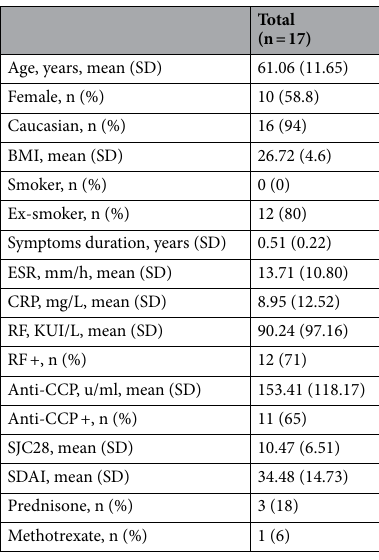
Table 1. Early RA patient cohort: characteristics at baseline. Anti-CCP anti-cyclic citrullinated peptide, BMI body mass index, CRP C-reactive protein, ESR erythrocyte sedimentation rate, RF rheumatoid factor, SDAI simple disease activity index, SJC28 swollen 28-joint count, % percentage after excluding missing